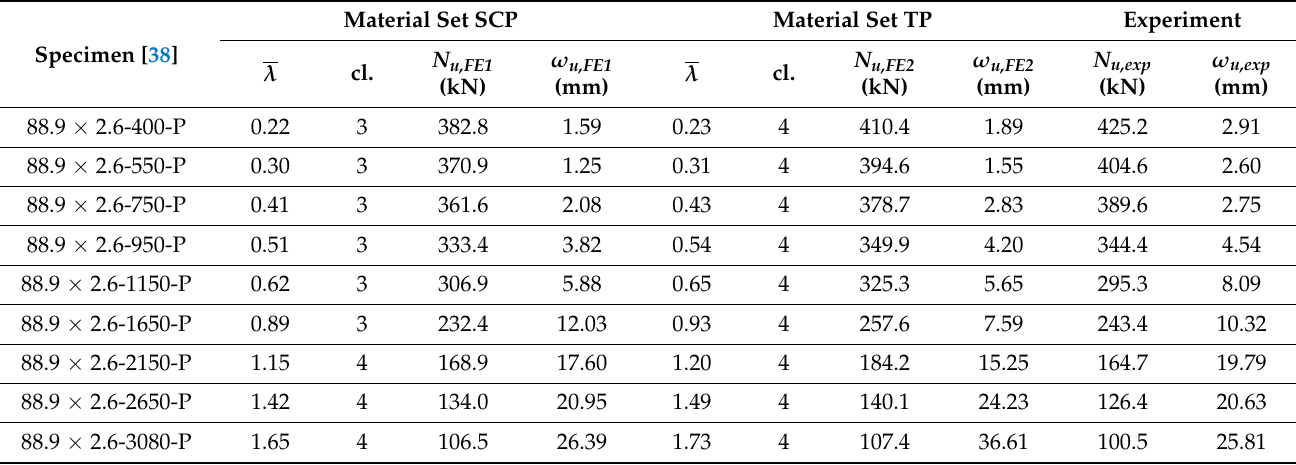
Table 10. Approach #A, FEA, and experiment results of the cross-section set 88.9 × 2.6 CHS pin-ended columns.